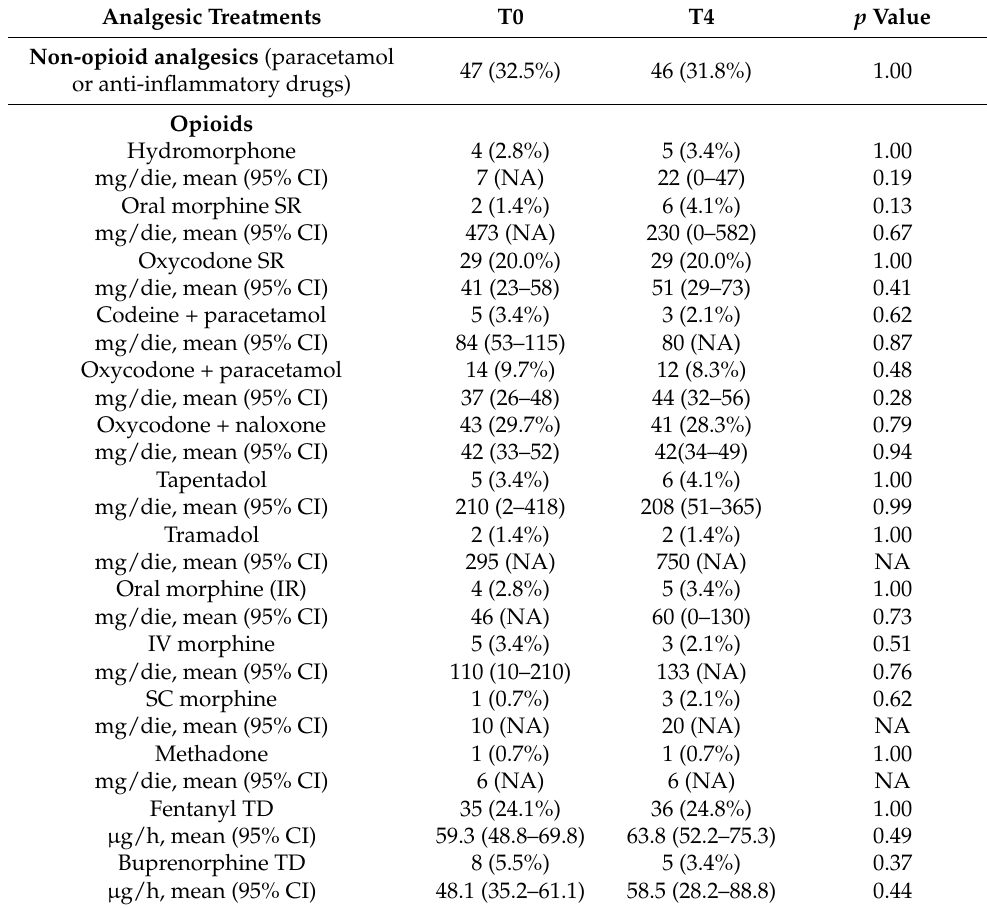
Table 2. Number of patients receiving opioids and mean doses (mg/die) (95% CI) used for back- ground